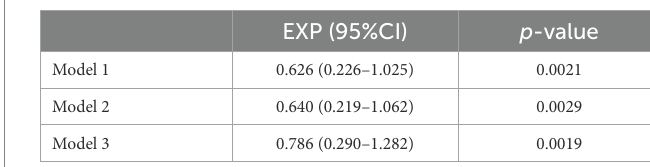
TABLE 4 Logistic regression analysis of the association between the TyG index and HFA-PEFF score.